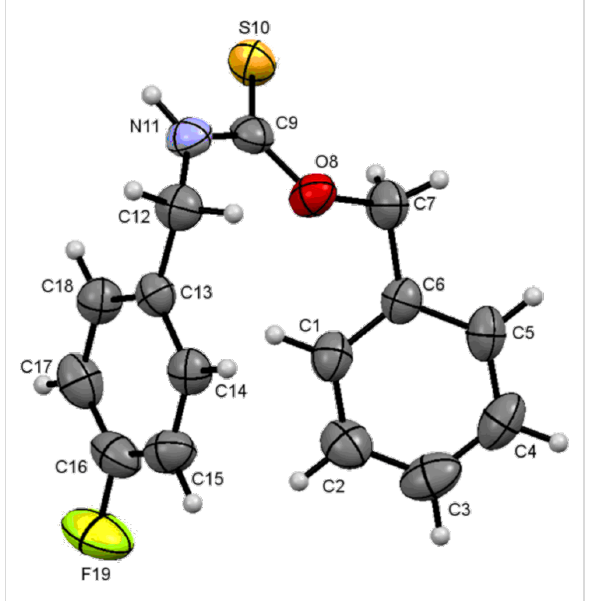
Figure 2: ORTEP diagram of O -benzyl (4-fluorobenzyl)carbamo- thioate ( 4c ).